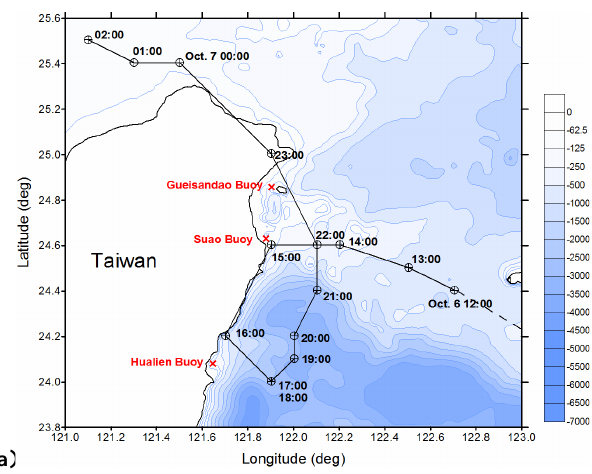
Fig. 2. (middle) Wind field provided by CWB (2009/10/6 13:00). The maximal mean wind speed near the typhoon centre is 51 m/s. The maximal gust wind is 63 m/s.